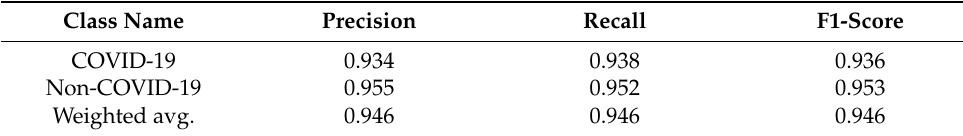
Table 1. Experimental results of evaluation